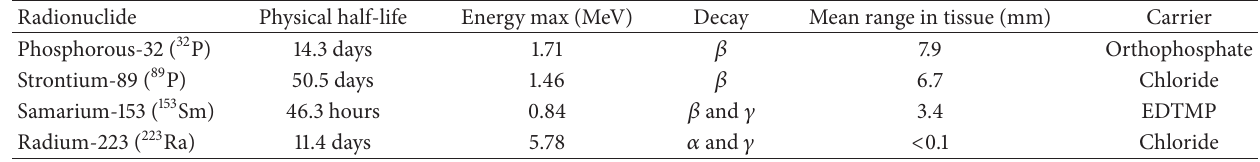
Table 2: Characteristics of bone-seeking